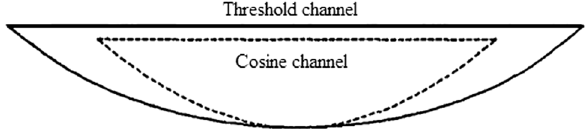
Fig. 10 Comparison of threshold channel and cosine channel profiles (Vigilar and Diplas